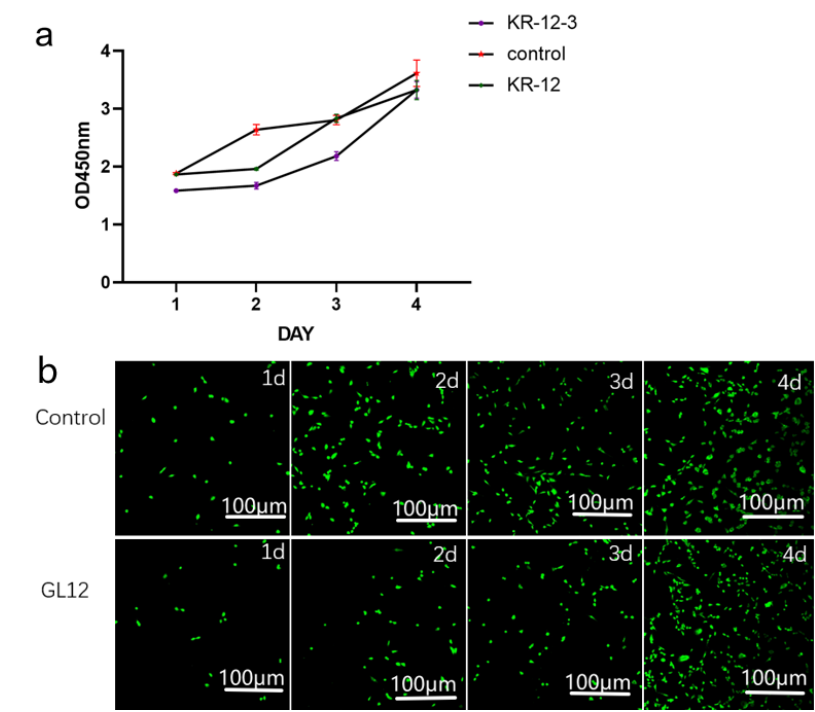
Figure 5. Proliferation curve of MC3T3-E1 cells treated with or without KR-12-3 and KR-12 for 1 –